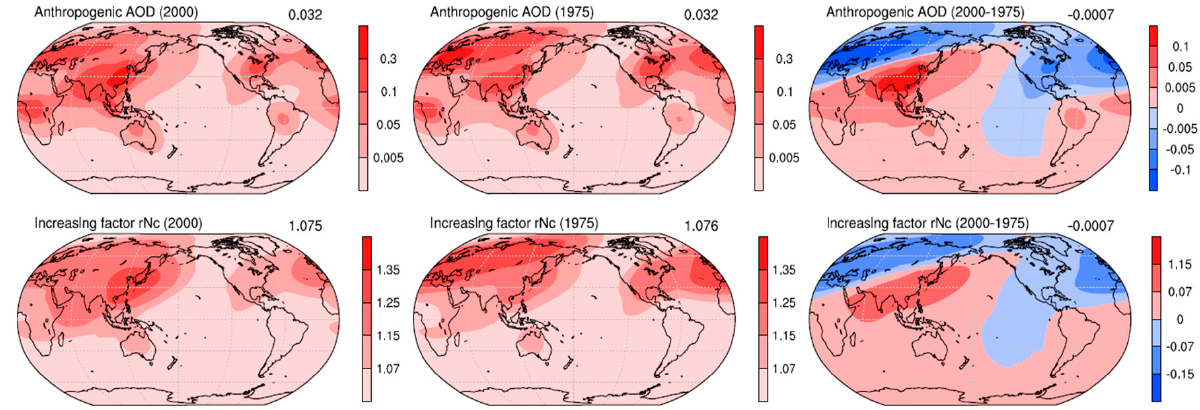
Figure 7. Anthropogenic aerosol optical depth in the visible band (AOD, upper panels) and the increasing factor for cloud droplet number (rNc, lower panels) provided by MACv2-SP for 2000 ( left ), 1975 ( middle ), and their difference ( right ). The global average is given in the upper-right corner.